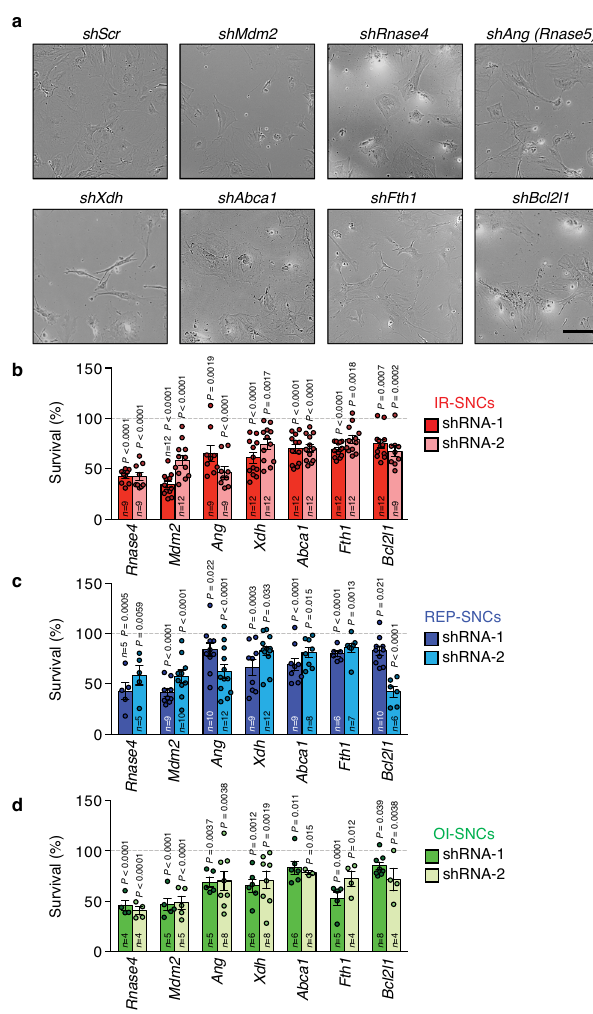
Fig. 2 Six SASE genes are commonly required to sustain SNC survival. a Images of IR-senescent MEFs 6 days after shRNA-mediated knockdown of the indicated SASE genes. Images are representative of 3 independent experiments. b – d Survival of IR- b , REP- c , and OI-SNCs d at day 6 after SASE gene knockdown with two independent shRNAs per gene. Survival was measured by MTS assay. Comparisons were made to SNCs of same cultures infected with scrambled shRNA ( shScr ; 100% line). Scale bar, 200 μ m. Data represent means ± SEM. n depict independent MEF lines that were pooled from 2 to 4 independent experiments. Statistics: one-way ANOVA with Sidak ’ s correction in b – d . Source data are provided as a Source Data fi